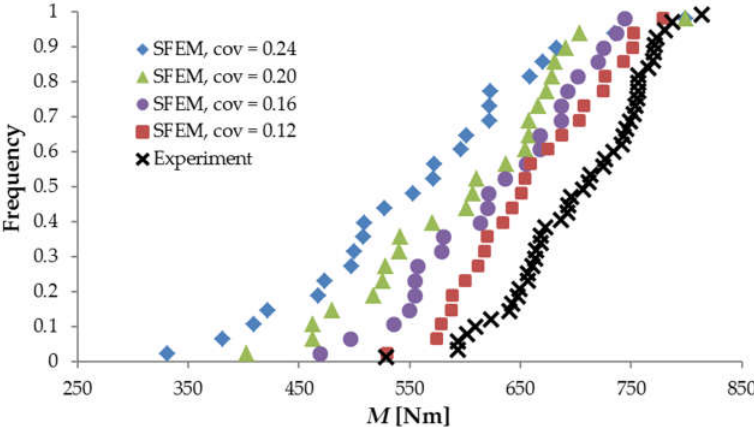
Figure 7. The original frequency diagrams for beam LM200 obtained for different material cov compared with the experimental results of Koide et al. (Copyright Permission, Proceedings of FRAMCOS-3, 1998 and Proceedings of ICASP-8, 2000) [7,8].